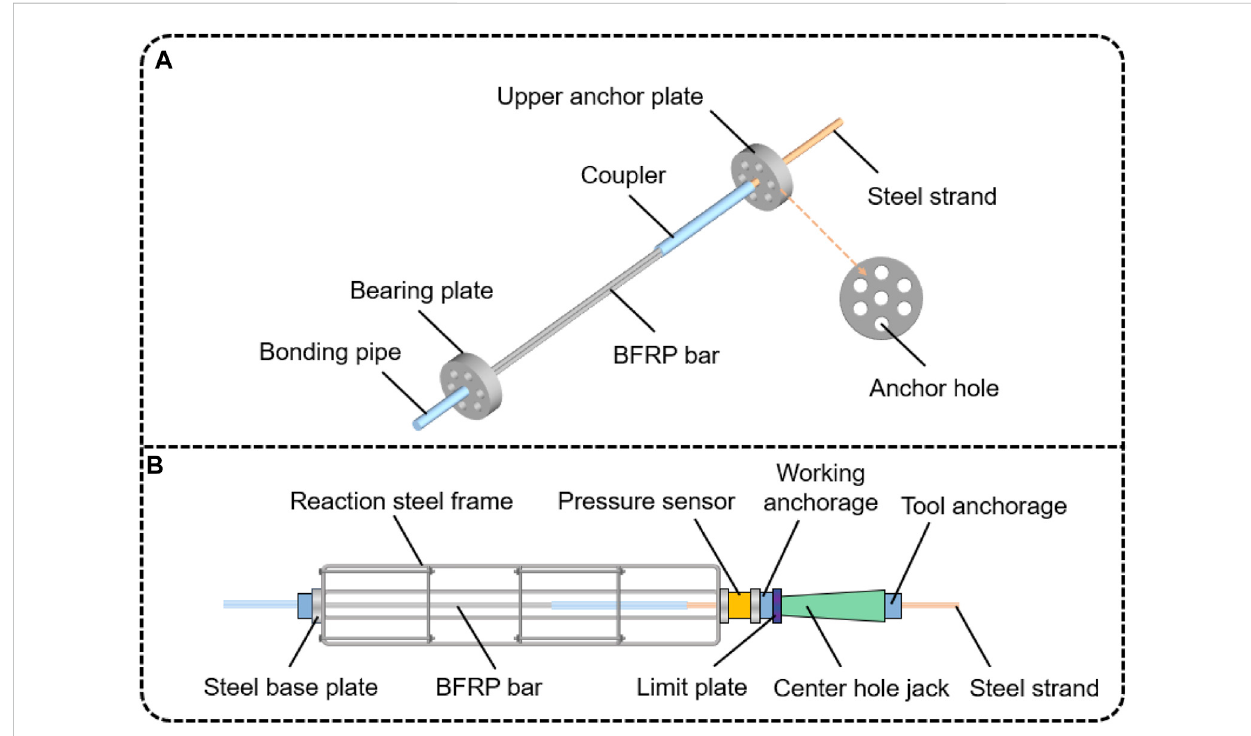
FIGURE 5 Structure of the SBCAS and the corresponding tension device: (A) Structure of the SBCAS, (B) Tension device of the SBCAS.